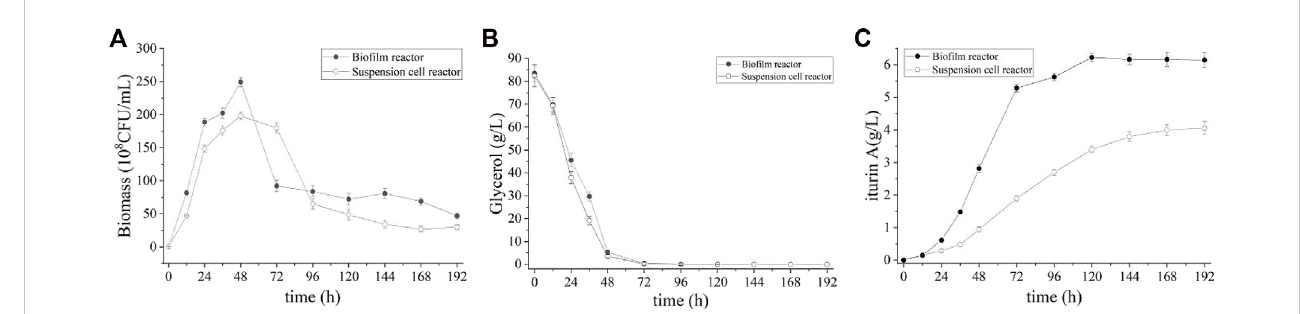
Timecourseofbiomass (A) ,residualglycerol (B) ,and iturinA production (C) during thebatchfermentationinsuspensioncell reactorand bio fi lmreactor with a step-wise temperature control